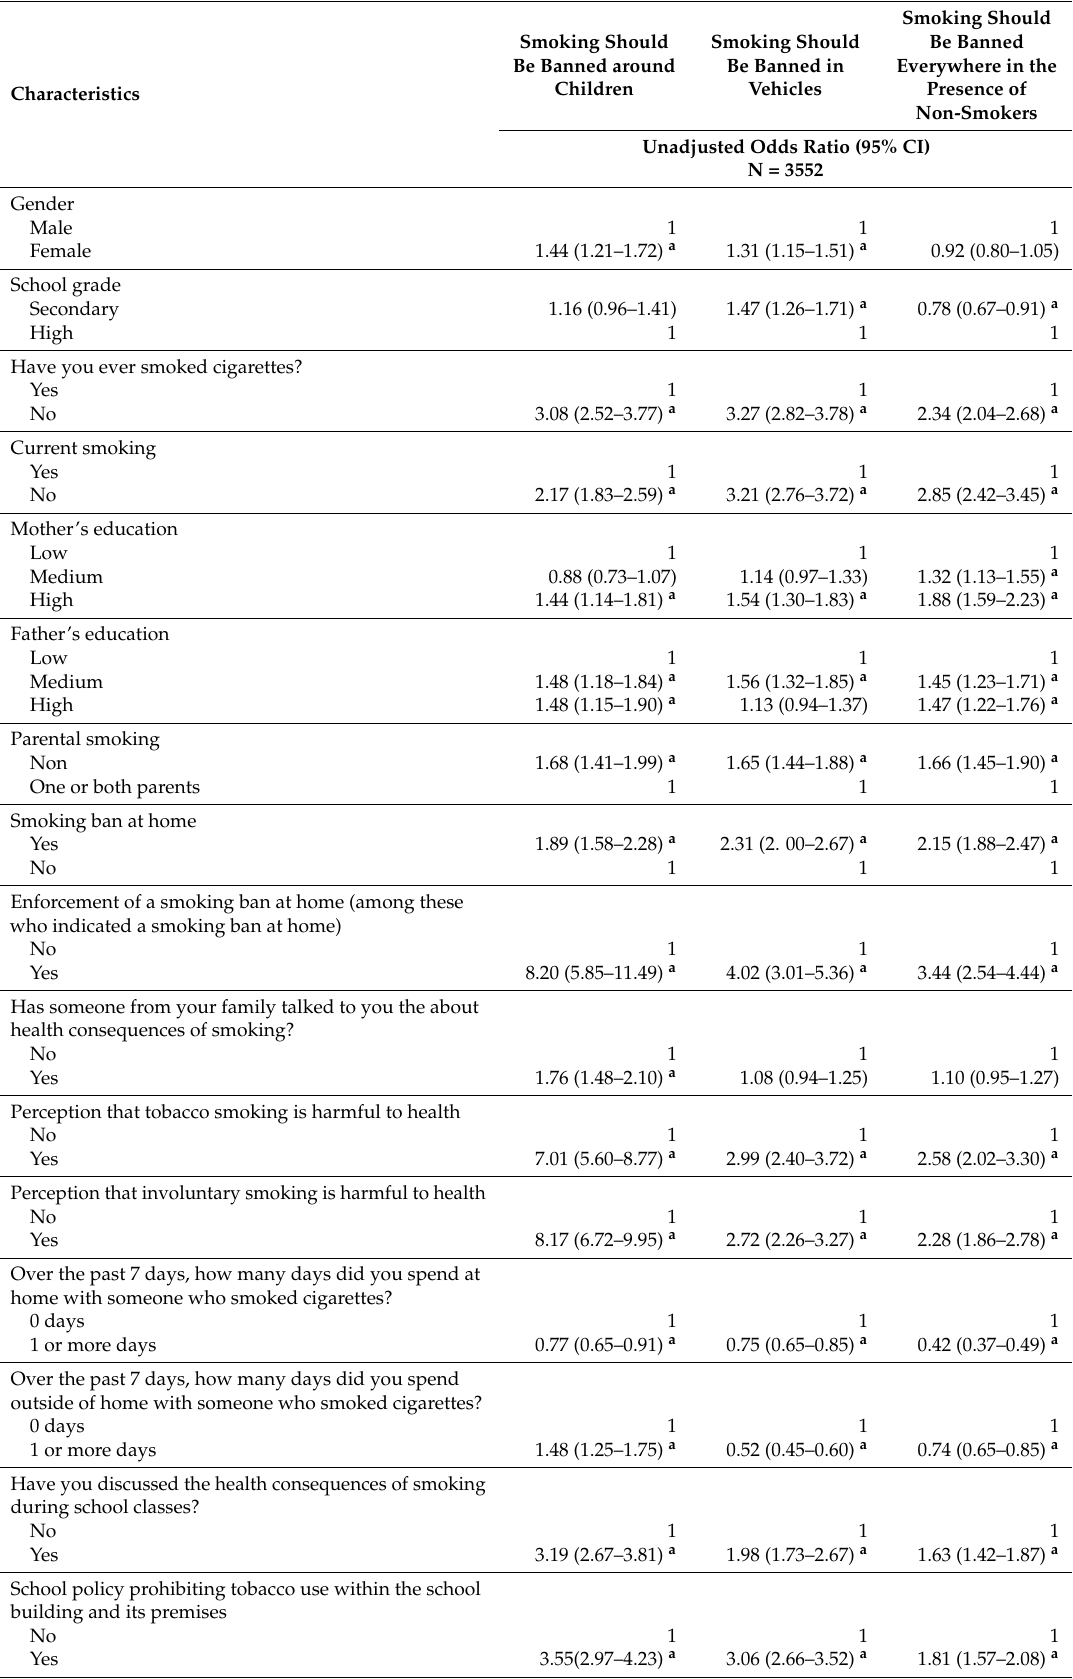
Table 2. Factors associated with the attitudes of young people towards restricting smoking in the presence of